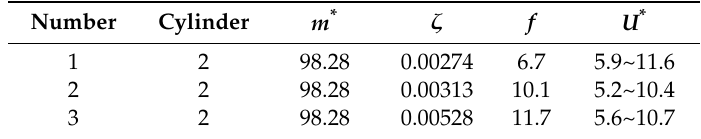
Table 2. Parameters of experiment I model.